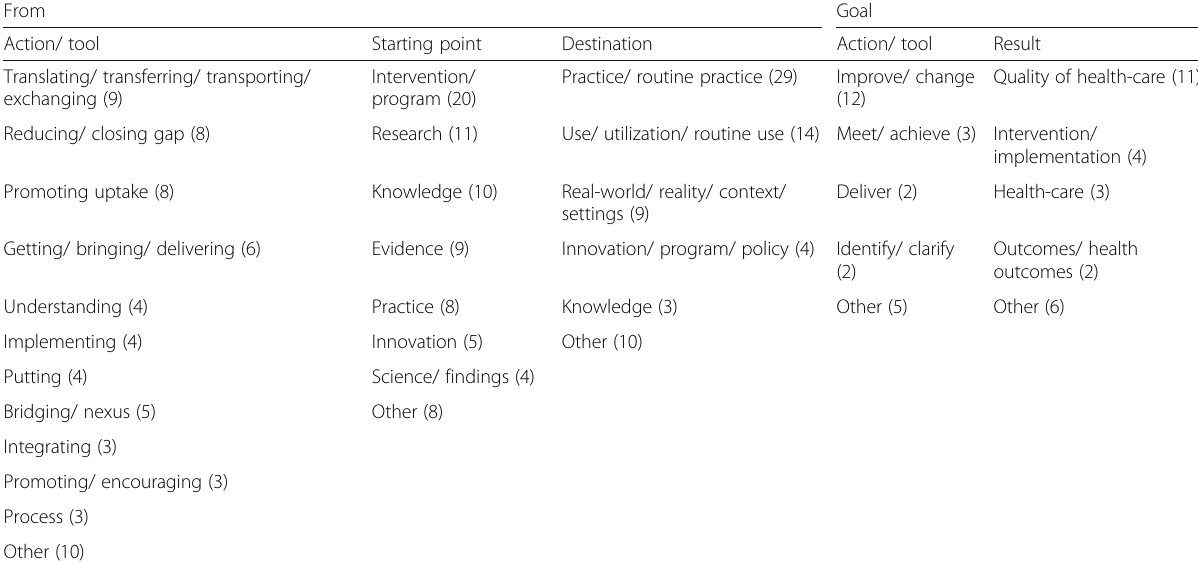
Table 1 Words used in different definitions of “ implementation science ” From Goal Action/ tool Starting point Action/